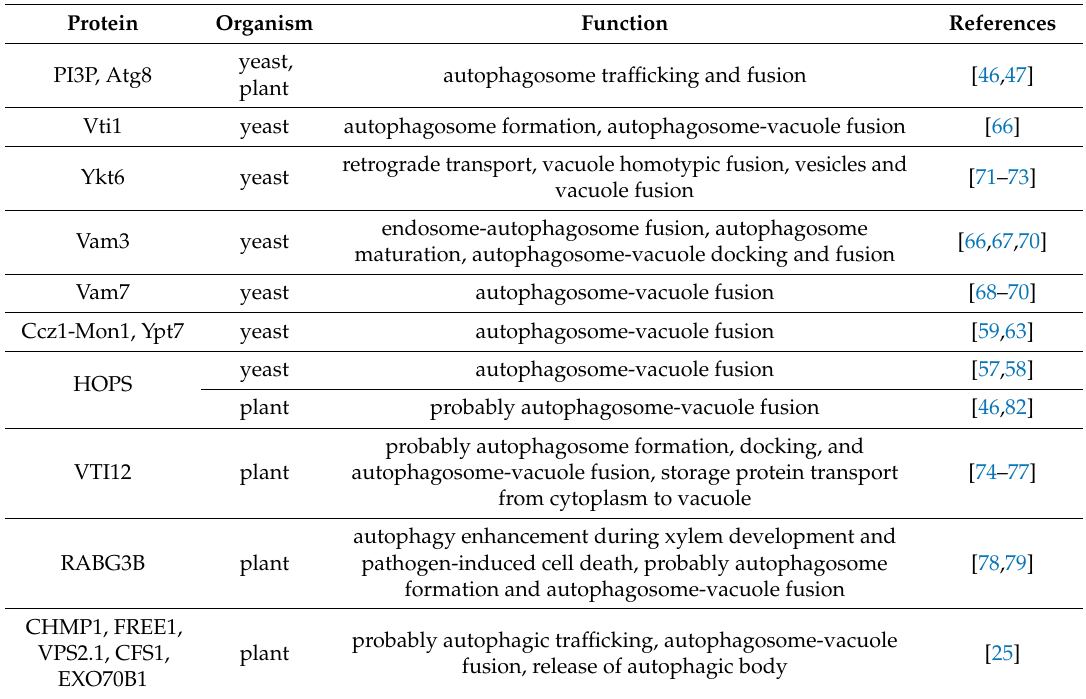
Table 1. Proteins involved, or hypothetically involved, in tra ffi cking and fusion of the autophagosome to the vacuole and formation of the autophagic body during